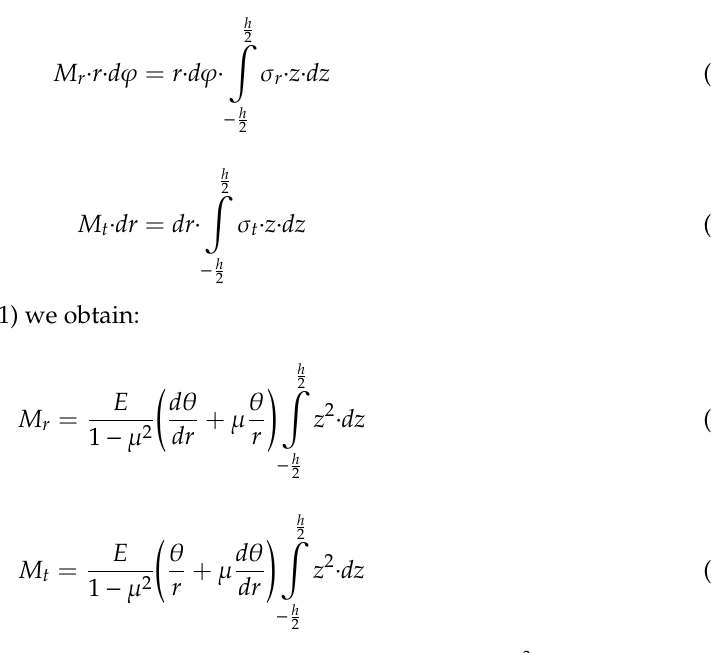
Figure 4. Forces and bending momentums acting on the differential element.